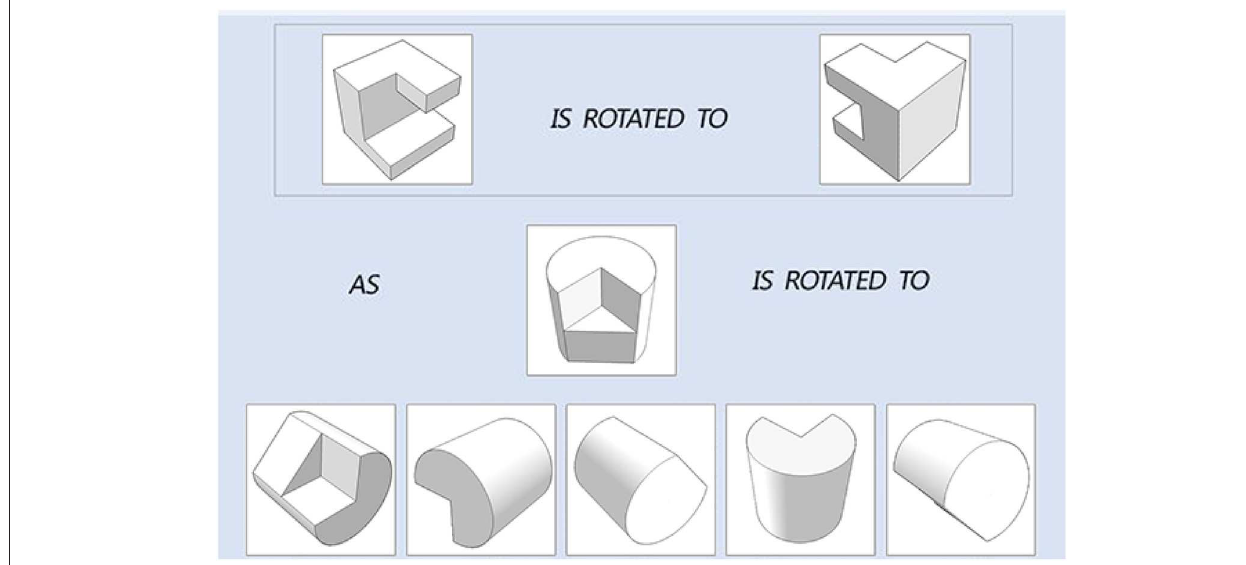
FIGURE 9 | The item (ID: N10) with largest guessing parameter g .